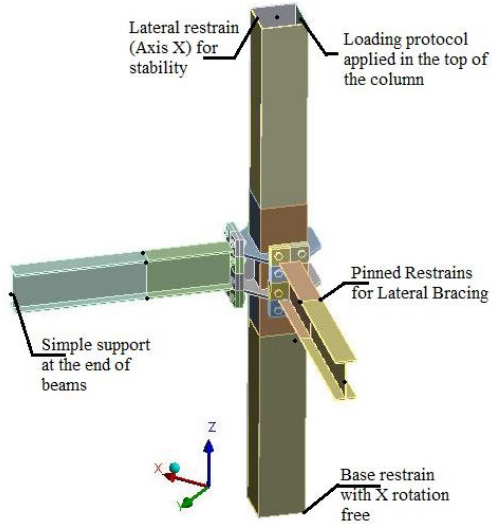
Figure 5. Boundary conditions used in the numerical model.